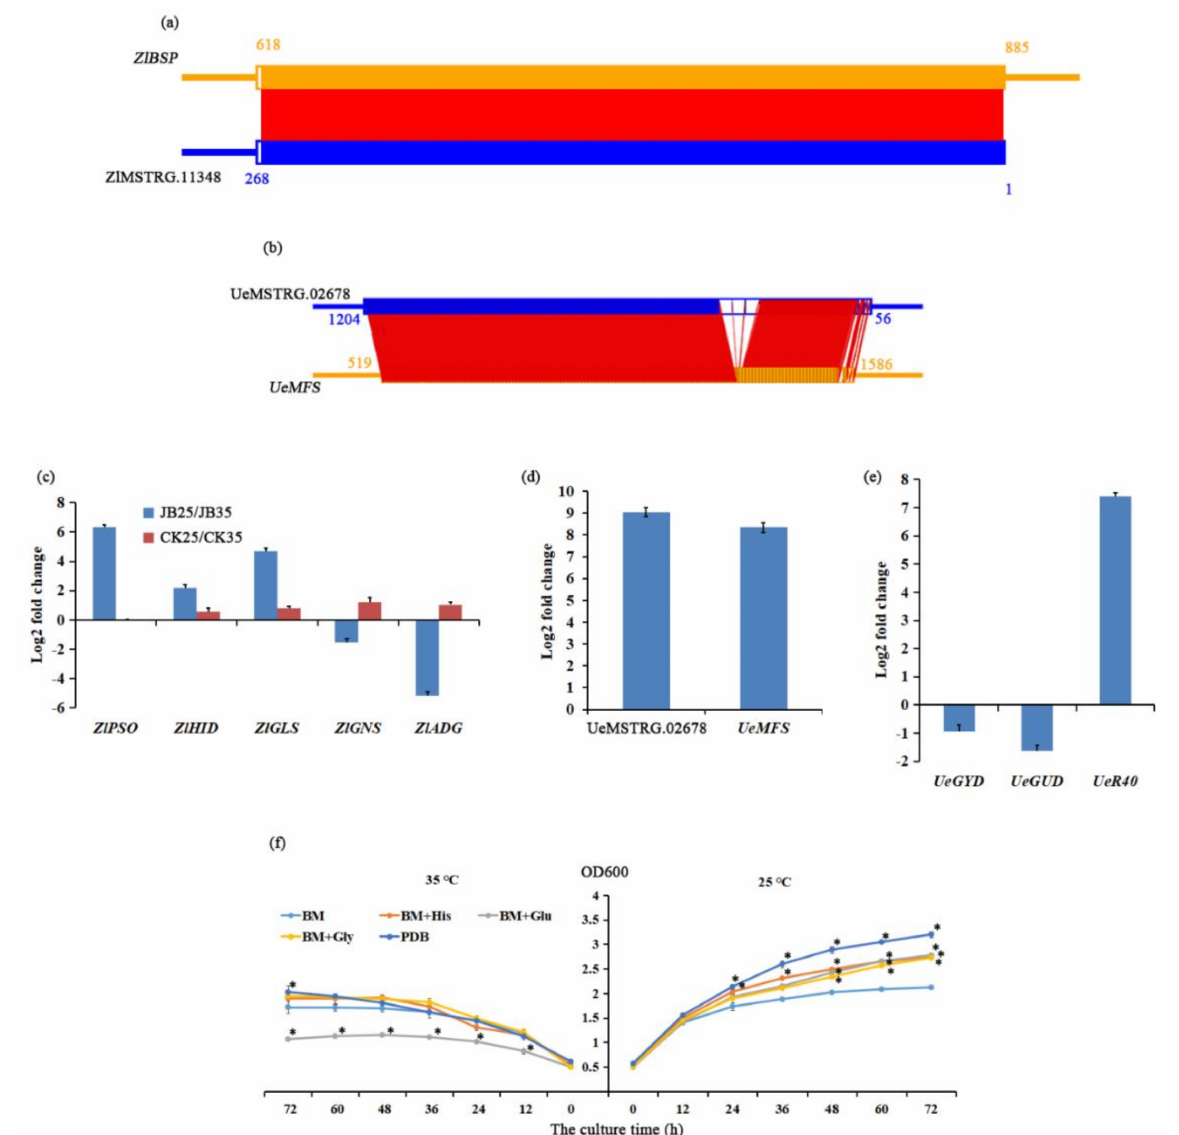
Figure 7. Analysis of lncRNA and genes related to amino acid metabolism. ( a , b ) Schematic dia-gram showing the antisense lncRNA-mRNA interaction between lncRNA ZlMSTRG.11348 and ZlBSP (bark storage protein) gene and between lncRNA UeMSTRG.02678 and UeMFS (major facil-itator superfamily transporter) gene. ( c ) qRT-PCR analysis of genes involved in amino acid metab-olism. ZlPSO , probable sarcosine oxidase. ZlHID , histidinol dehydrogenase. ZlGLS , glutamate synthase; ZlGNS , glutamine synthetase; ZlADG , aldehyde dehydrogenase. JB25 and JB35 represent culms of Zizania latifolia infected with Ustilago esculenta grown at 25 ◦ C and 35 ◦ C, respectively. CK25 and CK35 represent culms of Z. latifolia without U. esculenta infection grown at 25 ◦ C and 35 ◦ C, respectively. ( d ) qRT-PCR validation for the lncRNA UeMSTRG.02678 and its cis -target gene UeMFS in U. esculenta in JB25 and JB35 plants. ( e ) qRT-PCR analysis of genes involved in amino acid metabolism in U. esculenta in JB25 and JB35 plants. UeGYD , glycine decarboxylase; UeGUD , glutamate decarboxylase; UeR40 , ribosomal 40S subunit protein. ( f ) Growth of U. escu-lenta under different amino acid treatments at 35 ◦ C (left) and 25 ◦ C (right) in vitro. * indicates sig-nificant difference between treatment and control ( p < 0.05). BM, basic medium; His, histidine; Glu, glutamic acid; Gly, glycine; PDB, potato dextrose